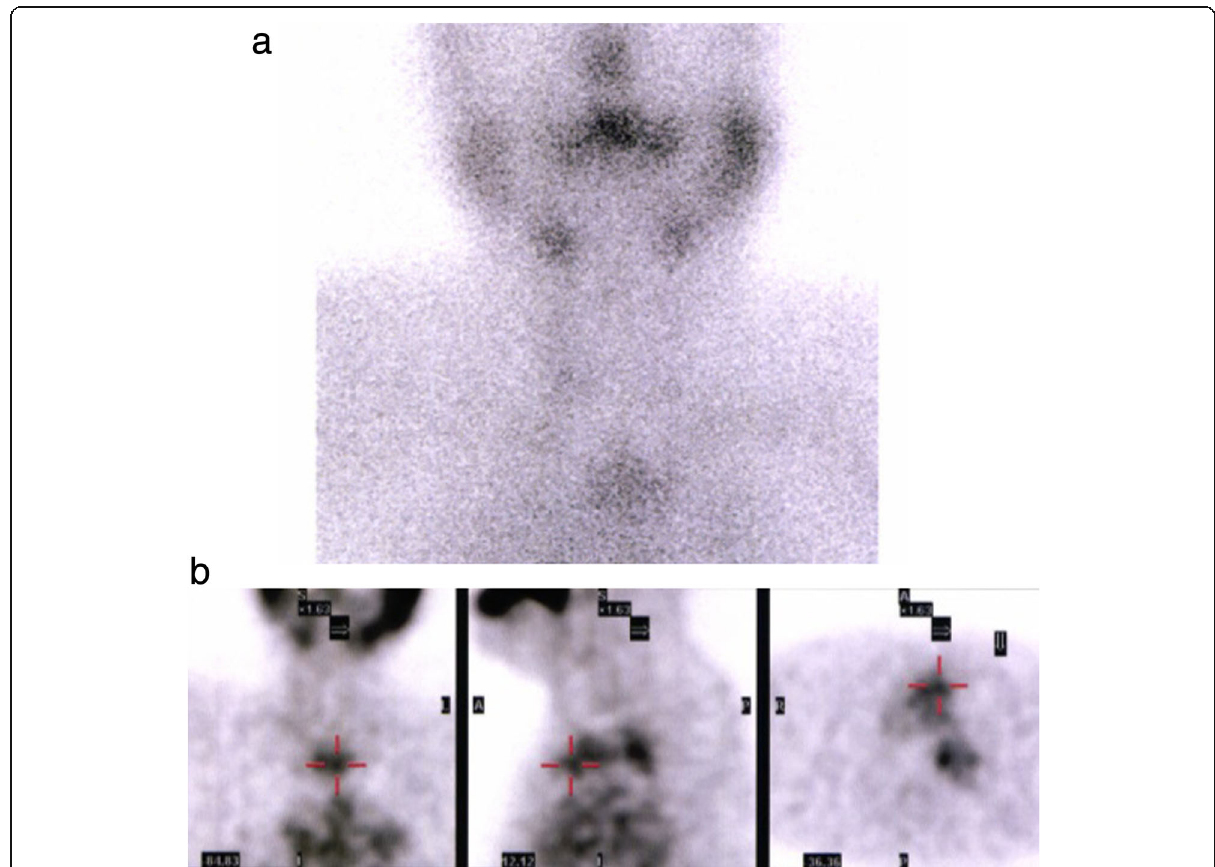
Fig. 4 a , b Radionuclide thyroid scan demonstrating mediastinal anterior functioning thyroid